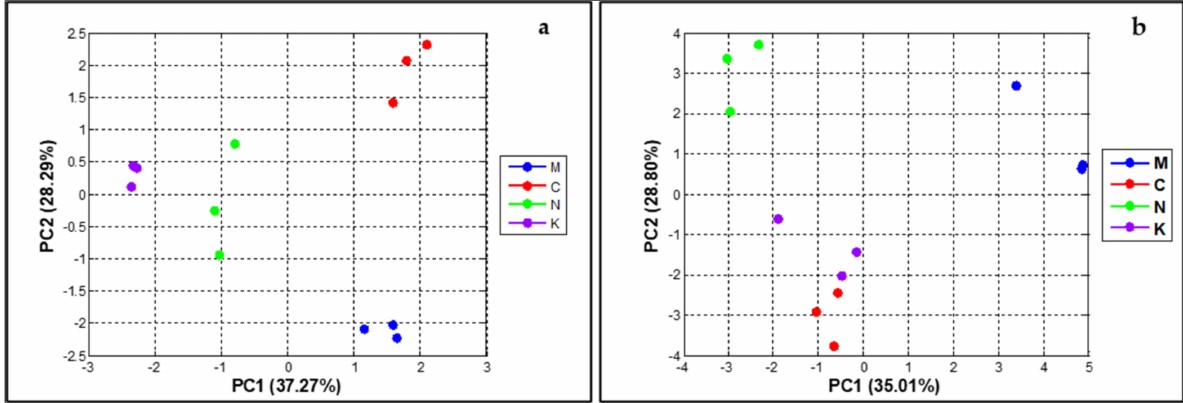
Figure 4. The chemometric PCA score plots of proximate compositions ( a ) and of physiological characteristics and proximate compositions ( b ) (‘mahachanok’; M, ‘chok anan’; C, ‘nam dok mai’; N, ‘kaew’; K). The representative points of each variety that are far apart indicate that the characteristics of fruit and peel of the mangoes are significantly different.